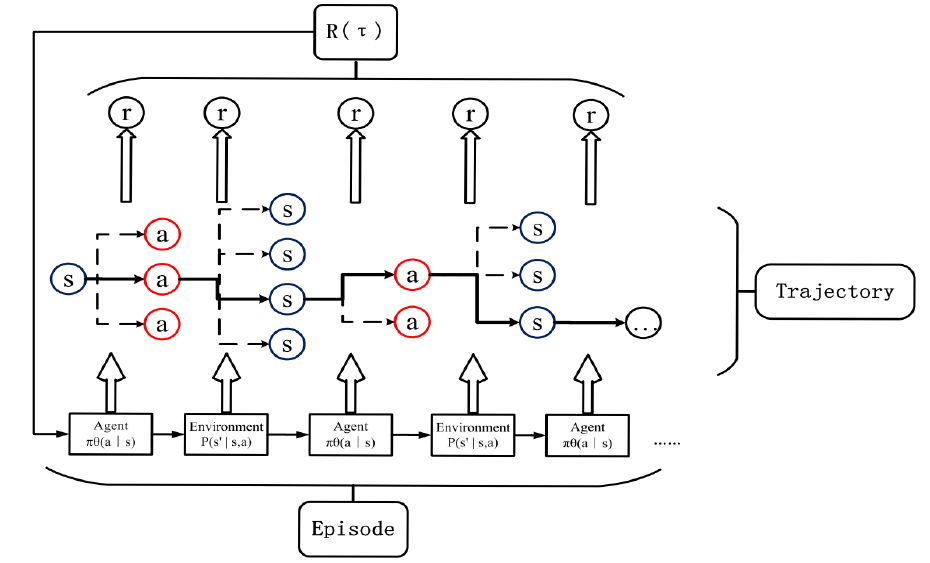
Figure 5. Policy Gradient